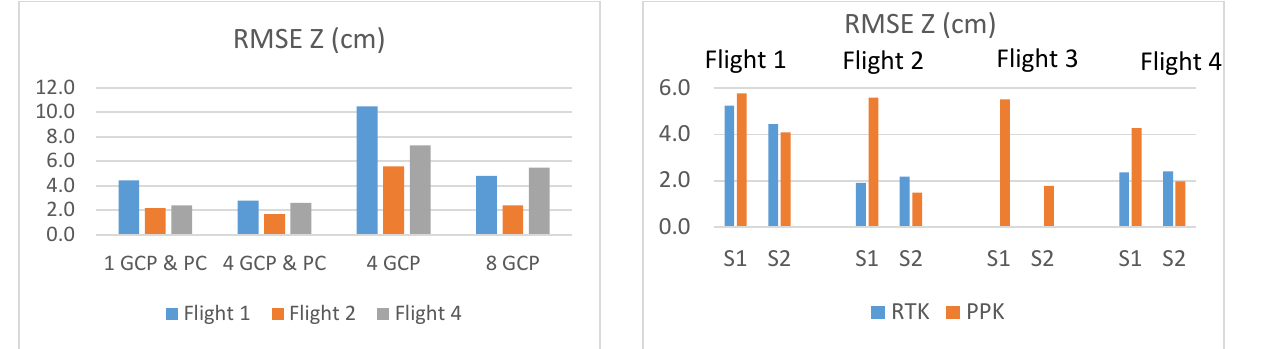
Figure 11. RMSE of the horizontal coordinates in the S1 and S2 Cases for the flight data from RTK and from a PPK solution.